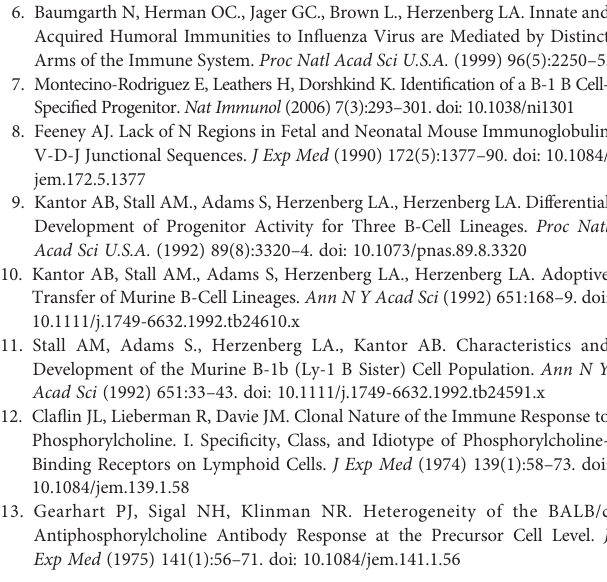
Supplementary Table 1 | List of differentially expressed genes in B-1b over B-1a cells from bulk RNAseq analysis. Supplementary Table 2 | Replicate CDR-H3 amino acid sequences (those present more than once) and frequency present in sorted PerC B-1a, B-1b,